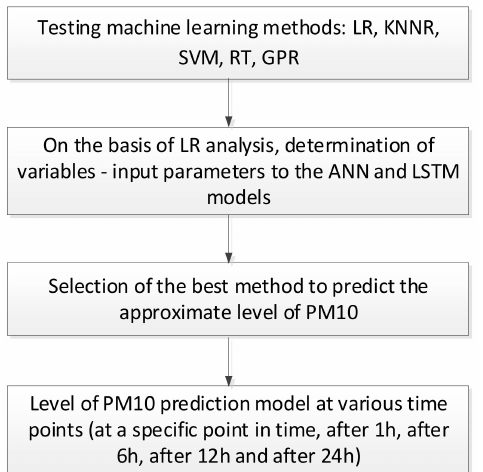
Figure 1. Scheme of the methodology used to conduct the